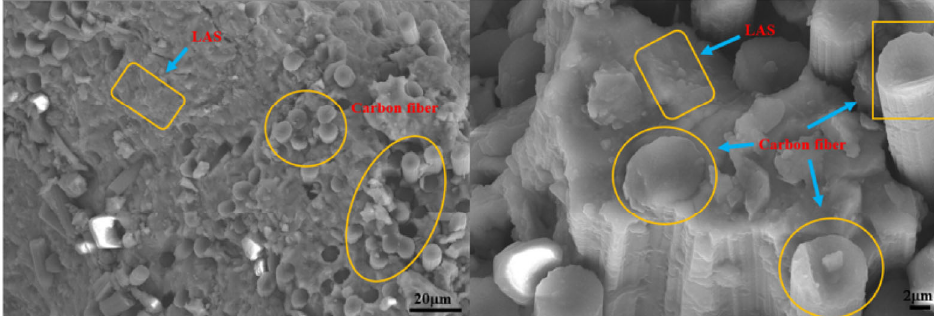
Fig. 1 Fracture interface of prepared C f /LAS